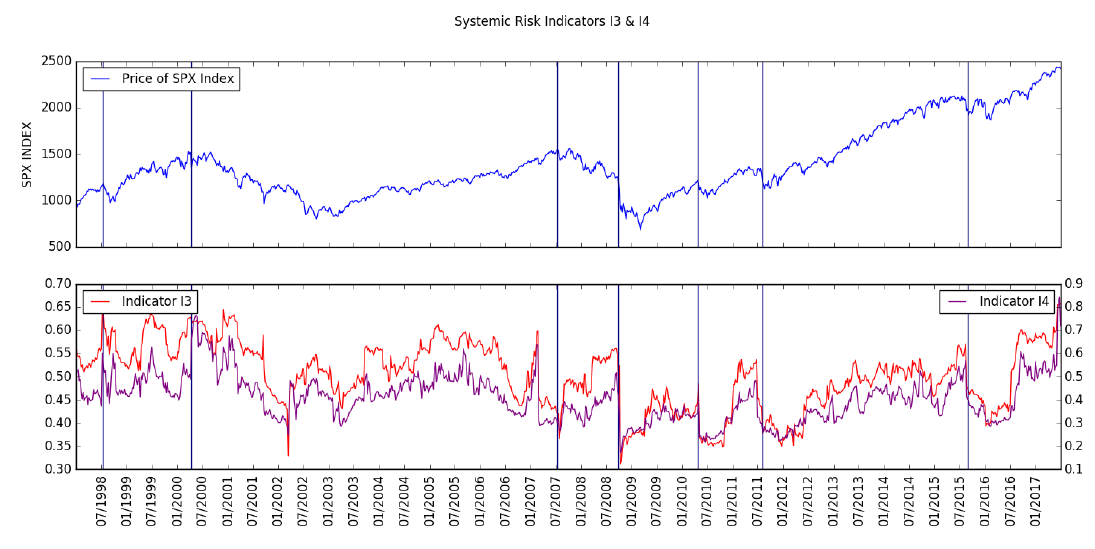
Figure 11. Systemic Risk Indicators I 3 and I 4 .